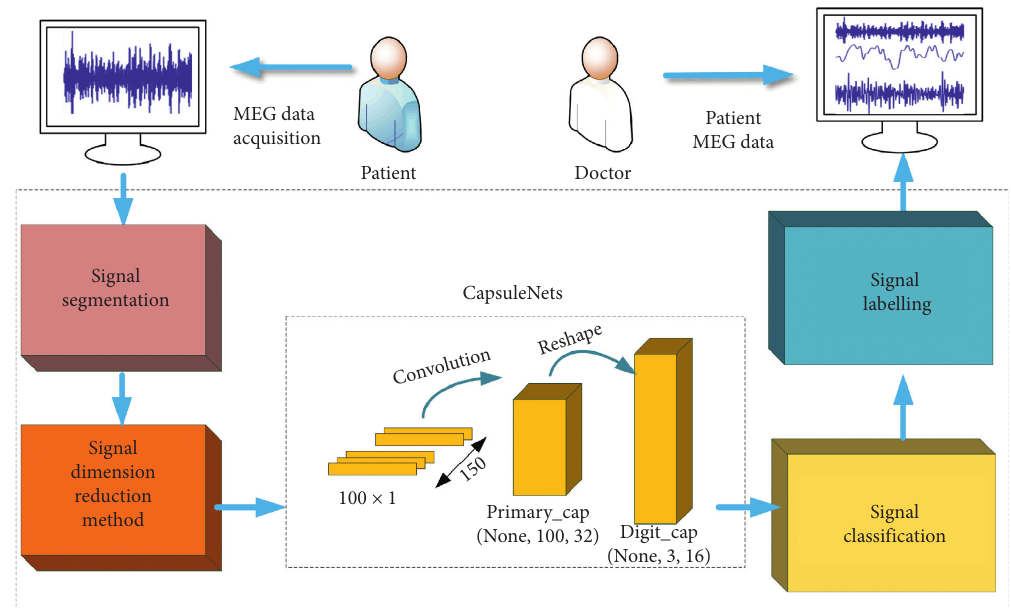
Figure 1: Overview of MEGNet detector working for HFOs detection in clinical